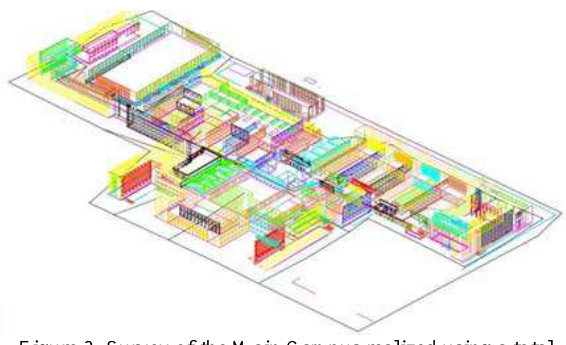
Figure 3. Survey of the Main Campus realized using a total station. (realized by Eraldo Mondino and Daniele Zaccaria)